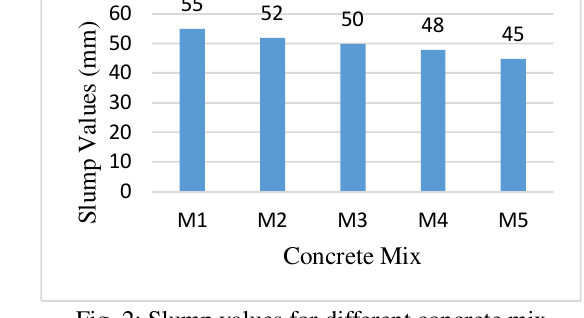
Fig. 2: Slump values for different concrete mix